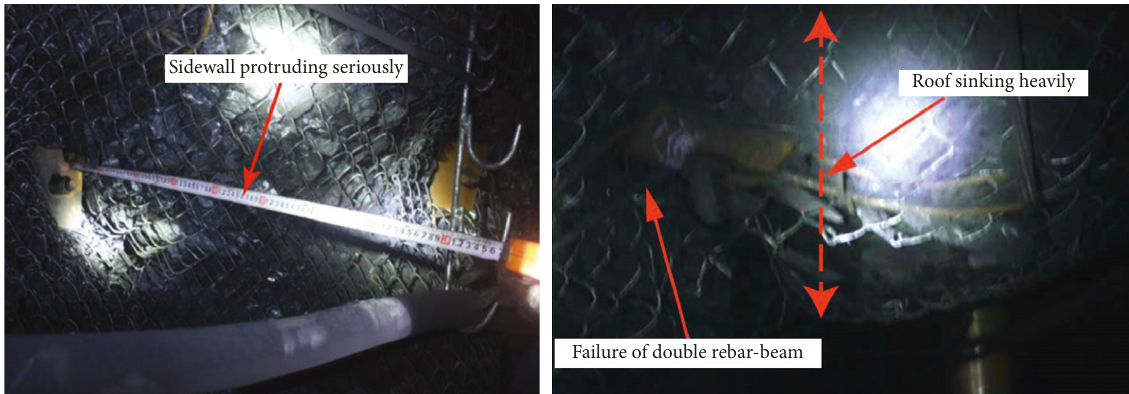
Figure 14: Typical failure modes of surrounding rock masses.